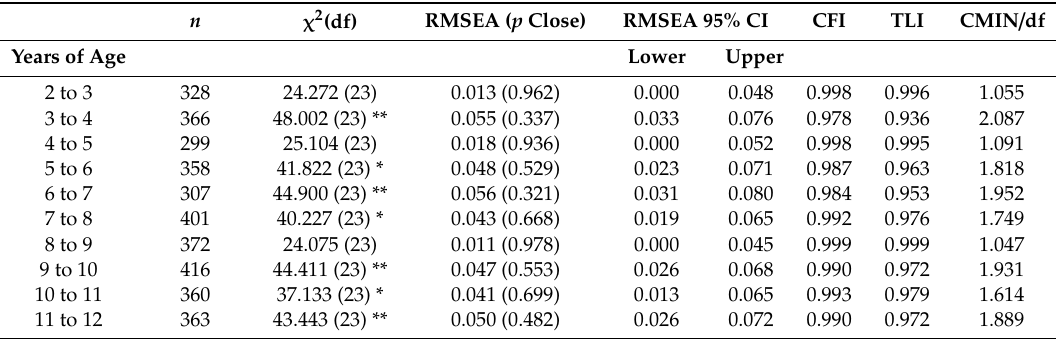
Table 4. Model fit indices of the cross-lagged panel analyses to examine bi-directionality of parental feeding practices and standardized child body mass